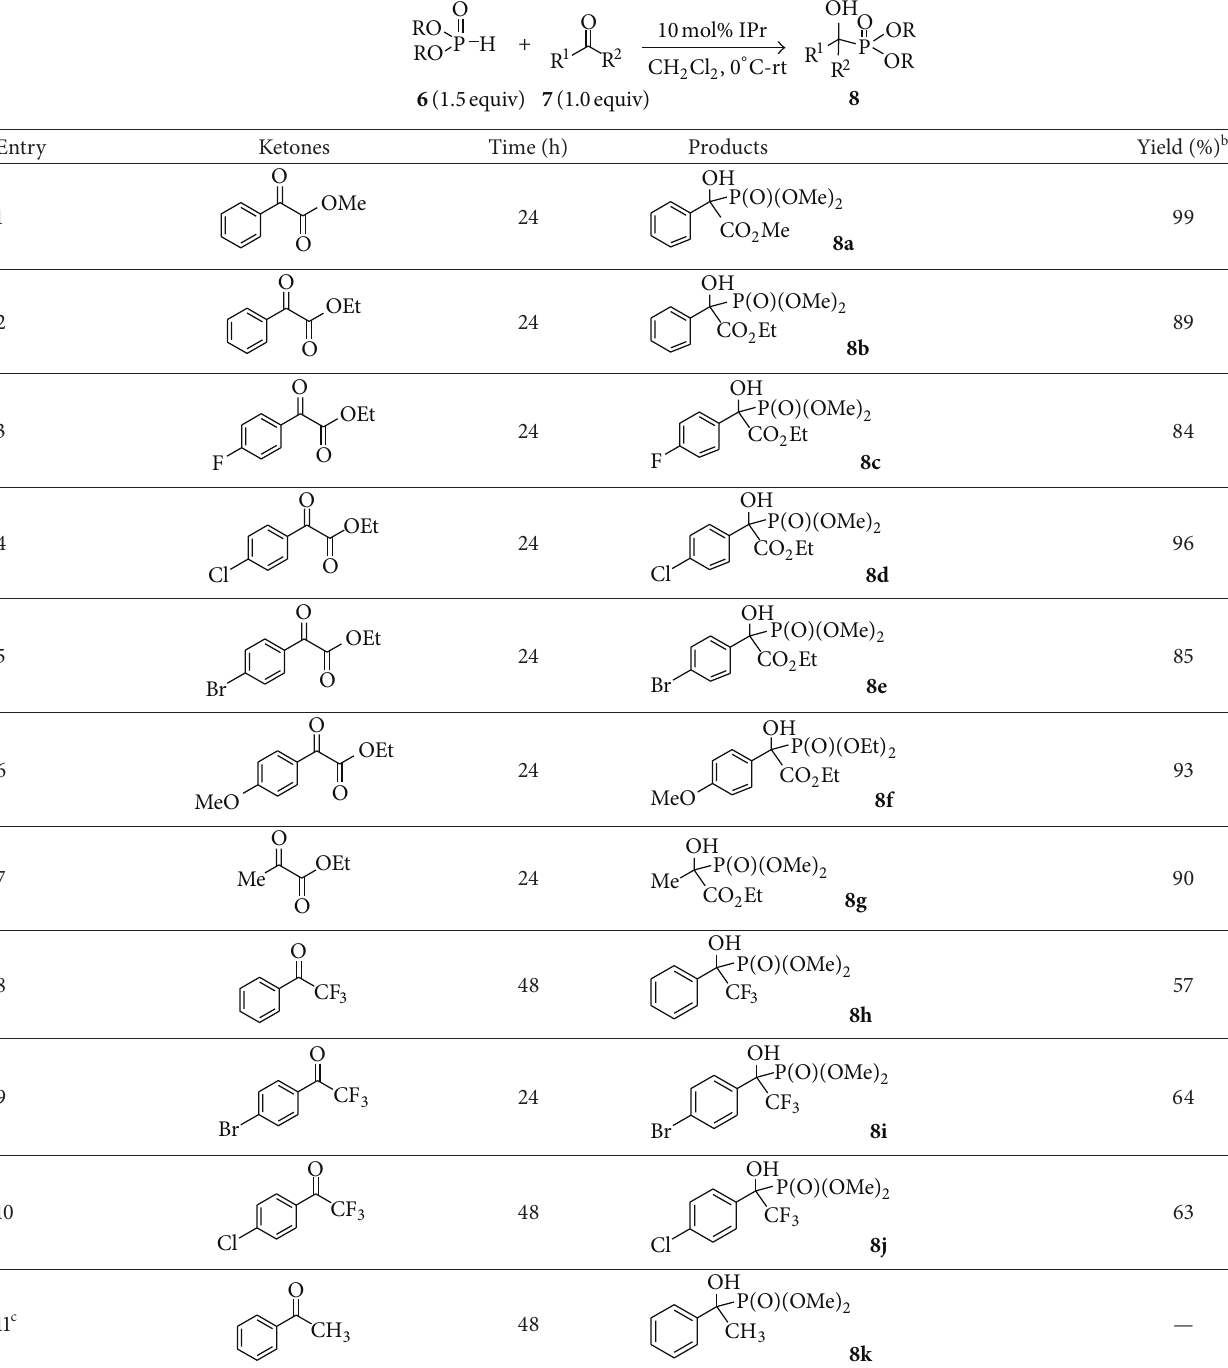
Table 2: NHC-catalyzed hydrophosphonylation of phosphites with active ketones a